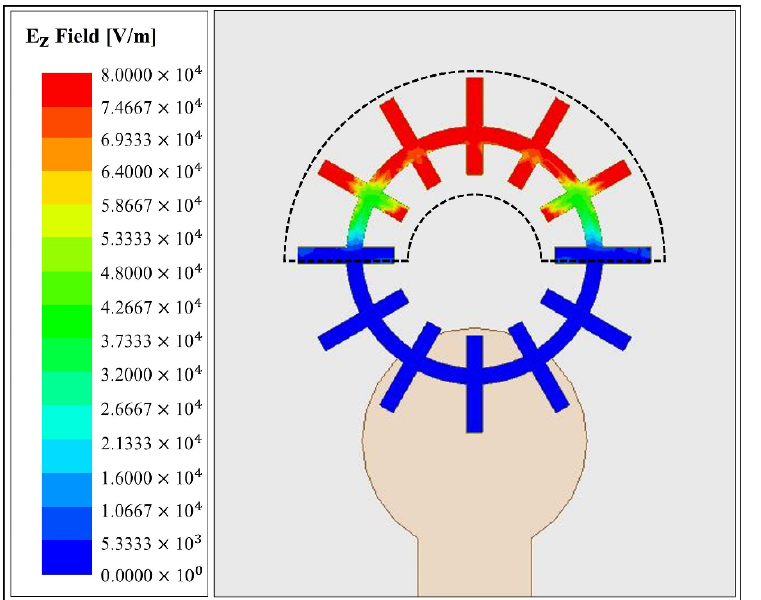
Figure 3. Simulated magnitudes of the E z vectors of the E-field at a resonant frequency of 37.02 GHz.